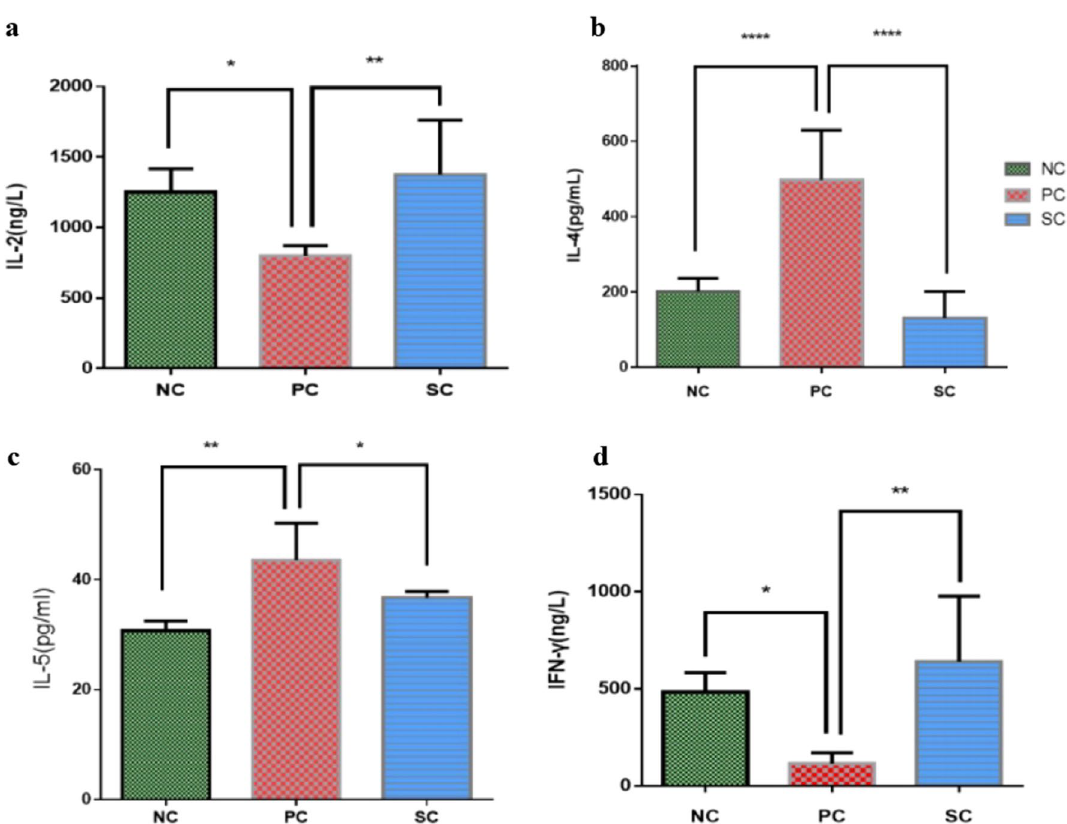
Figure 5. The content of cytokines in the serum of each group was determined by ELISA. Figure ( a ), ( b ), ( c ), and ( d ) show the levels of IL-2, IL-4, IL-5, and IFN-γ, respectively. *P < 0.05, **P < 0.01, ****P <